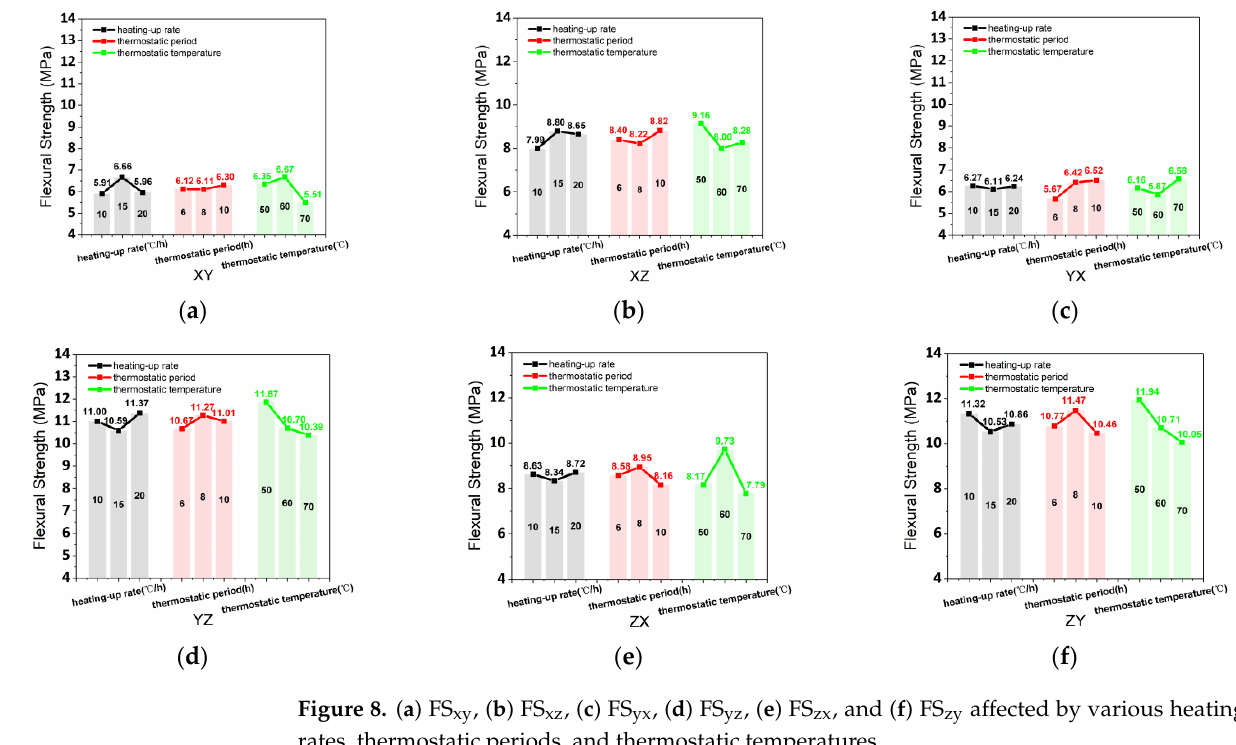
Figure 8. ( a ) FS xy , ( b ) FS xz , ( c ) FS yx , ( d ) FS yz , ( e ) FS zx , and ( f ) FS zy affected by various heating-up rates, thermostatic periods, and thermostatic temperatures. Table 10. Orthogonal experimental table of various test group designs, curing conditions, and anisotropy coefficient of mechanical